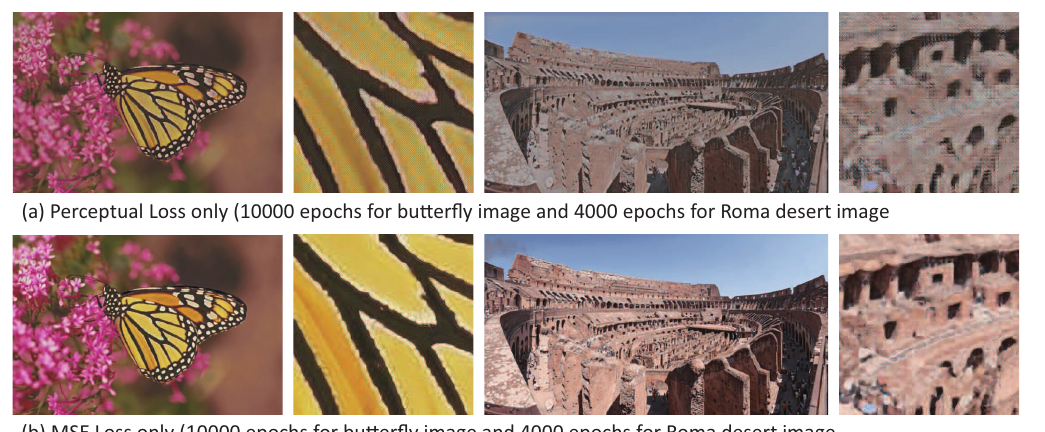
Figure 6. The comparison on perceptual loss and MSE loss: ( a )just perceptual loss. ( b )only MSE